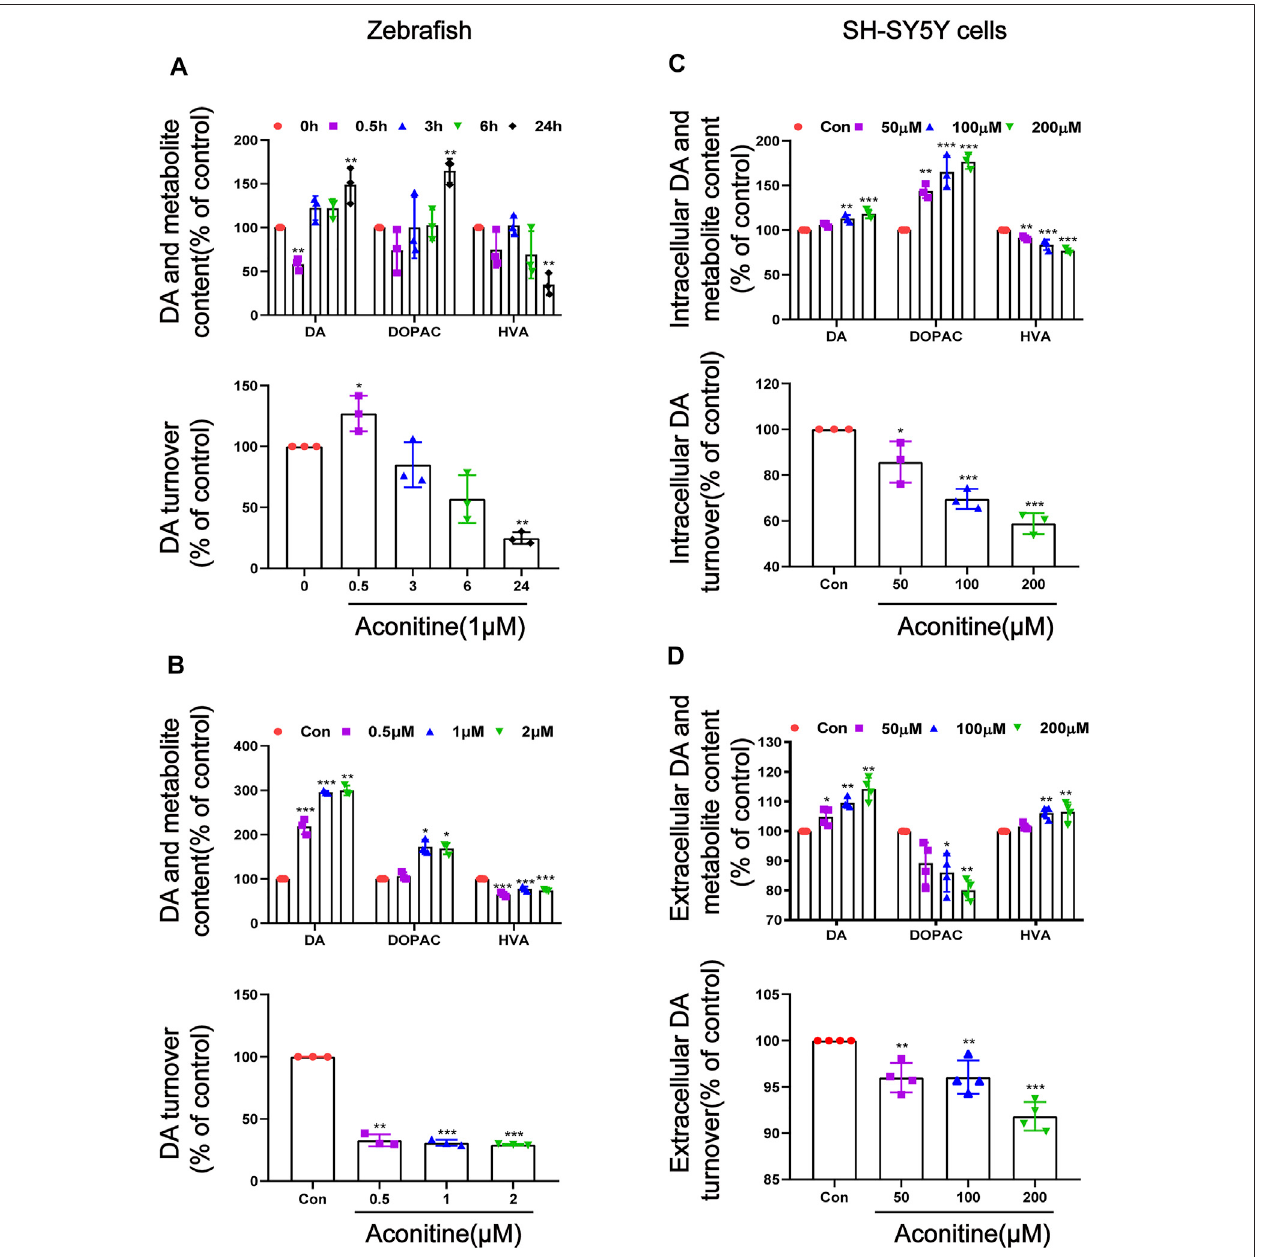
FIGURE 3 | Alteration of dopamine and its metabolites levels in zebra fi sh larvaes and SH-SY5Y cells after aconitine exposure. (A) Dopamine, DOPAC and HVA levelsandtheturnoverofdopamineafterlarvaesweretreatedwith1 μ Maconitinefor0.5,3,6,and24h,respectively. (B) Dopamine,DOPACandHVAcontentsandthe turnover of dopamine after larvaes were incubated with aconitine at doses of 0.5, 1 and 2 μ M for 24 h. (C) Intracellular dopamine, DOPAC and HVA levels and the turnoverofdopamineatdosesof50,100,and200 μ Mfor24 hinSH-SY5Ycells. (D) Extracellulardopamine,DOPACandHVAlevelsandtheturnoverofdopamine at doses of 50, 100, and 200 μ M for 24 h in SH-SY5Y cells. The values are expressed as mean ± SD, n = 3. * p < 0.05, ** p < 0.01, *** p < 0.001 vs. control groups.